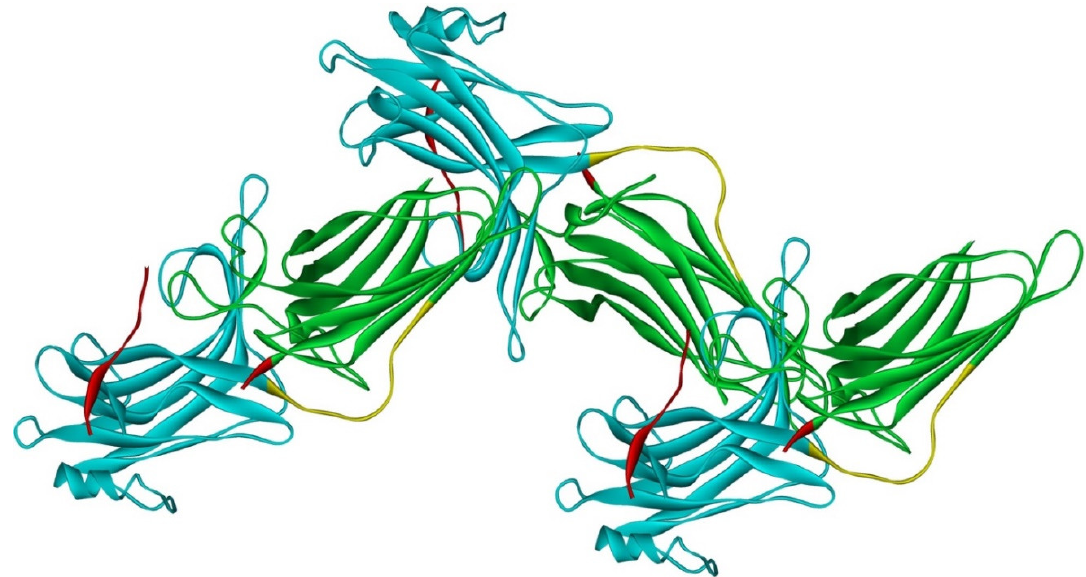
Figure 3. Crystal oligomer of bovine arrestin-2 in the presence of IP 6 . Based on PDB ID 1ZSH [68]. Arrestin-2 oligomer in the presence of IP6 appears to form the same “infinite” chains in solution [69], with each protomer in basal conformation, crystal structure of which was solved earlier (PDB ID 1G4M [26] and 1ZSH [27]). Arrestin-2 in crystal forms “infinite” chains with no apparent limit. Three molecules making IP 6 -mediated N-to-C contacts are shown. In each protomer arrestin-2 elements are colored, as follows: N-domain (residues 1–172), blue; inter-domain hinge (residues 173–184), yellow; C-domain (residues 185–352), green; C-tail (from residue 353), red (note the gap, as part of this element was not resolved in the crystal structure). Image was created in DS ViewerPro 6.0 (Dassault Systèmes, San Diego, CA, USA).